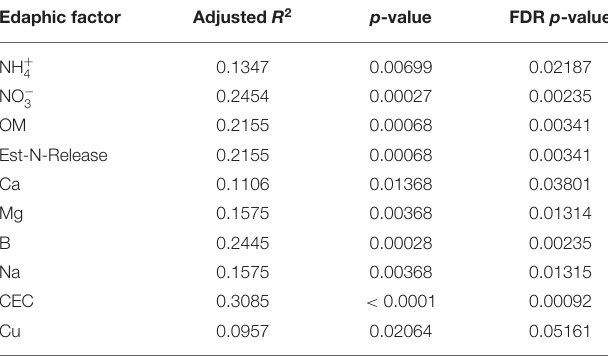
TABLE 2 | Results of one-way linear regressions assessing the influence of individual edaphic variables on natural-log transformed nitrification potential (NP)